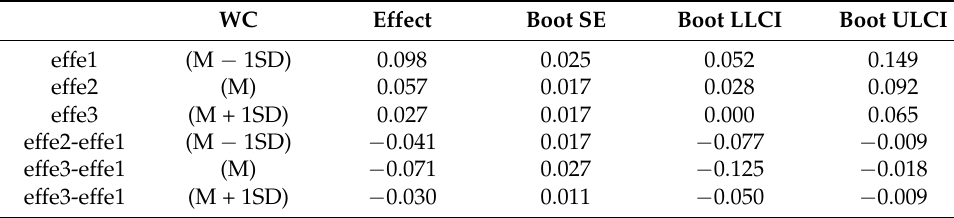
Table 6. Moderating effects at different levels of WC in Indirect effects (HPL → Ey →